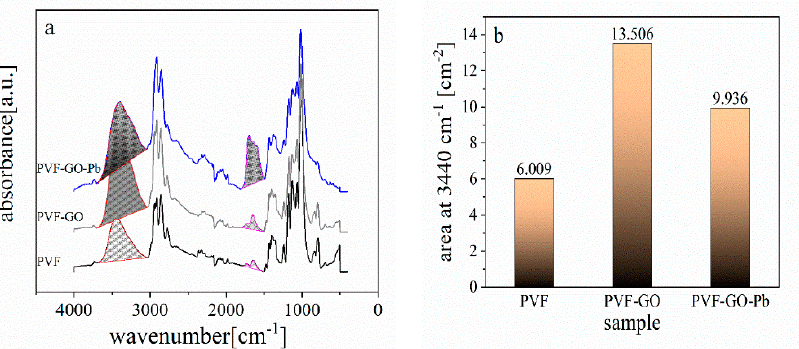
Figure 4. ATR-FTIR spectra of PVF/GO and PVF/GO/Pb composite compared to the pure PVF ( a ). The area under the peak in the wave number range from 3600 to 3100 cm − 1 in all samples was shown in ( b